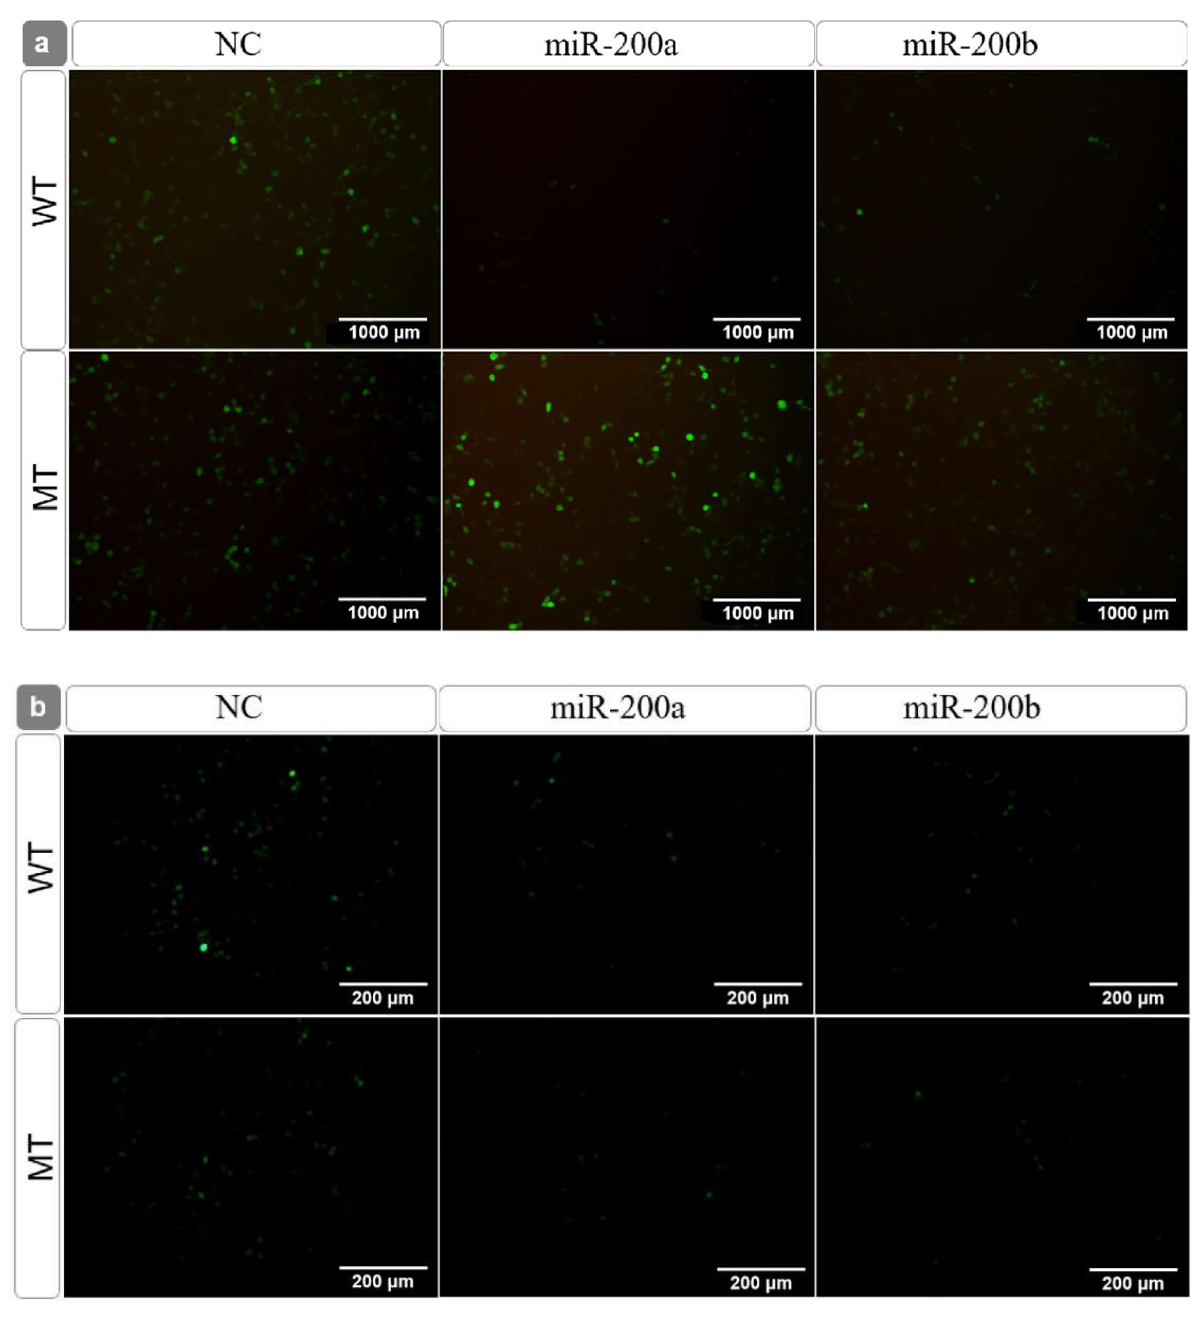
Figure 5. The fluorescence observation after the wild and mutant amh -pEGFP plasmid transfection. Note: ( a ) mutation site 1; ( b ) mutation site 2.